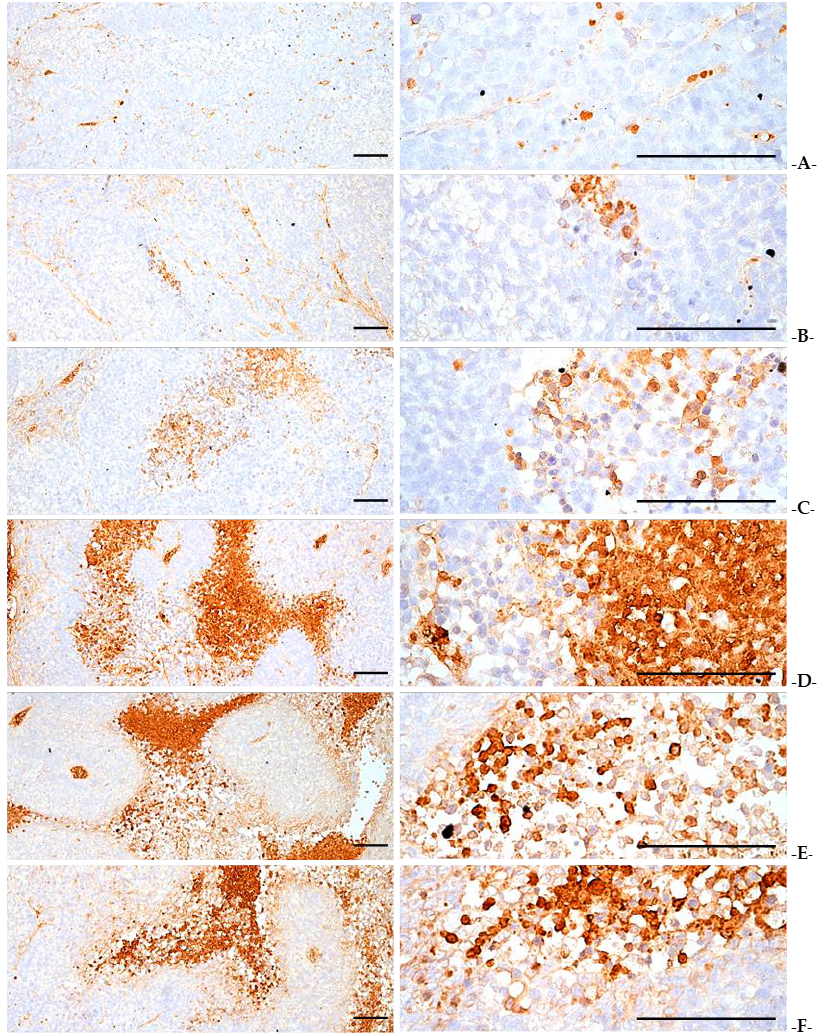
Figure 12. Representative TNF- α immunoreactivities of the tumor masses taken from NCI-H520 tumor cell xenograft mice. ( A ) = Tumor-bearing control; ( B ) = 120 mg/kg-gefitinib-single-treated rodents; ( C ) = 400 mg/kg-SKOG-single-treated rodents; ( D ) = gefitinib 120 mg/kg and SKOG 400 mg/kg; ( E ) = gefitinib 120 mg/kg and SKOG 200 mg/kg; ( F ) = gefitinib 120 mg/kg and SKOG 100 mg/kg. AR = Adenophorae Radix; KOG = Kyeongokgo ; SKOG = sasam-Kyeongokgo . TNF = tumor necrosis factor. All avidin-biotin complex (ABC) methods. Scale bars = 100 μm.